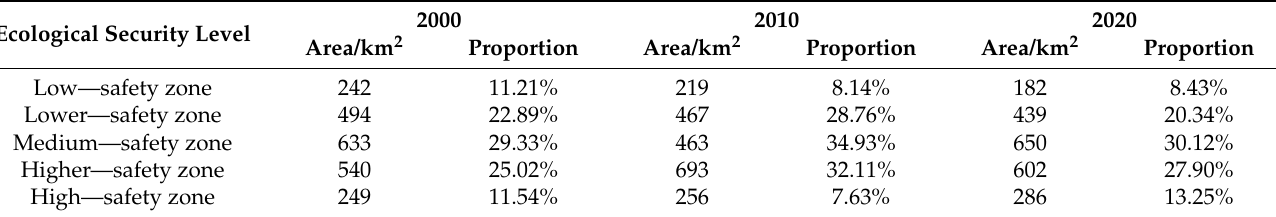
Figure 7. ( a ) Spatial distribution of landscape ecological security in 2000; ( b ) Spatial distribution of landscape ecological security in 2010; ( c ) Spatial distribution of landscape ecological security in 2020. Table 1. Statistics of landscape ecological security area in the study area.